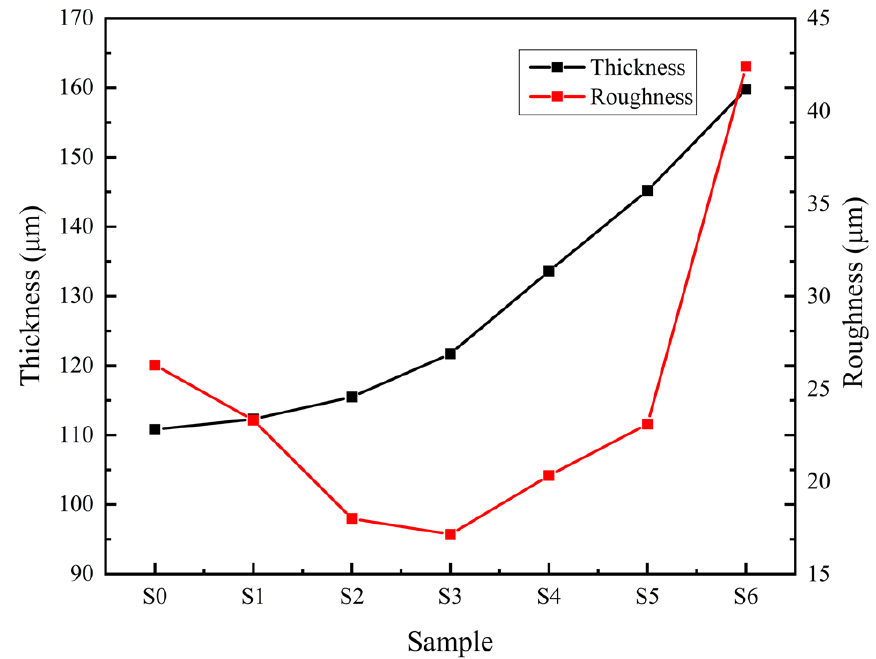
Figure 5. Thickness and roughness of MAO coatings.